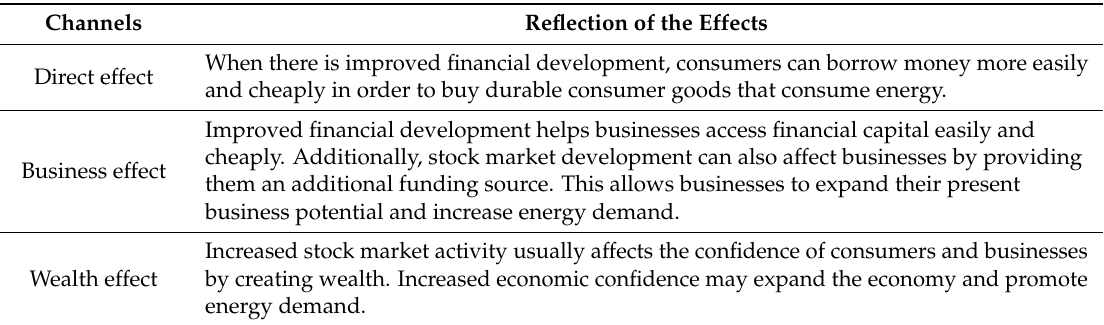
Table 1. How financial development affects energy